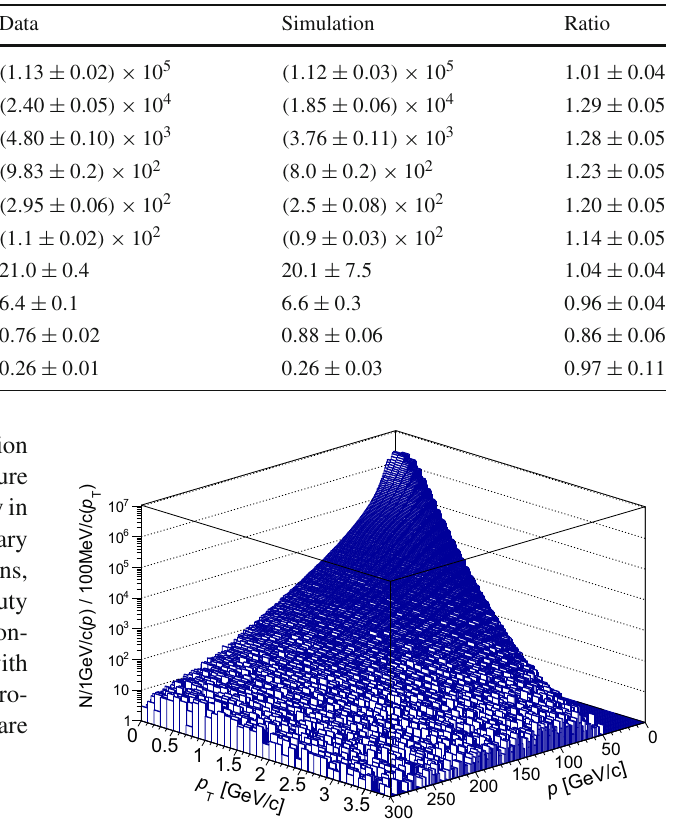
Fig. 8 p T vs p for data. The units on the vertical axis are the number of tracks per p , p T bin in the entire data set